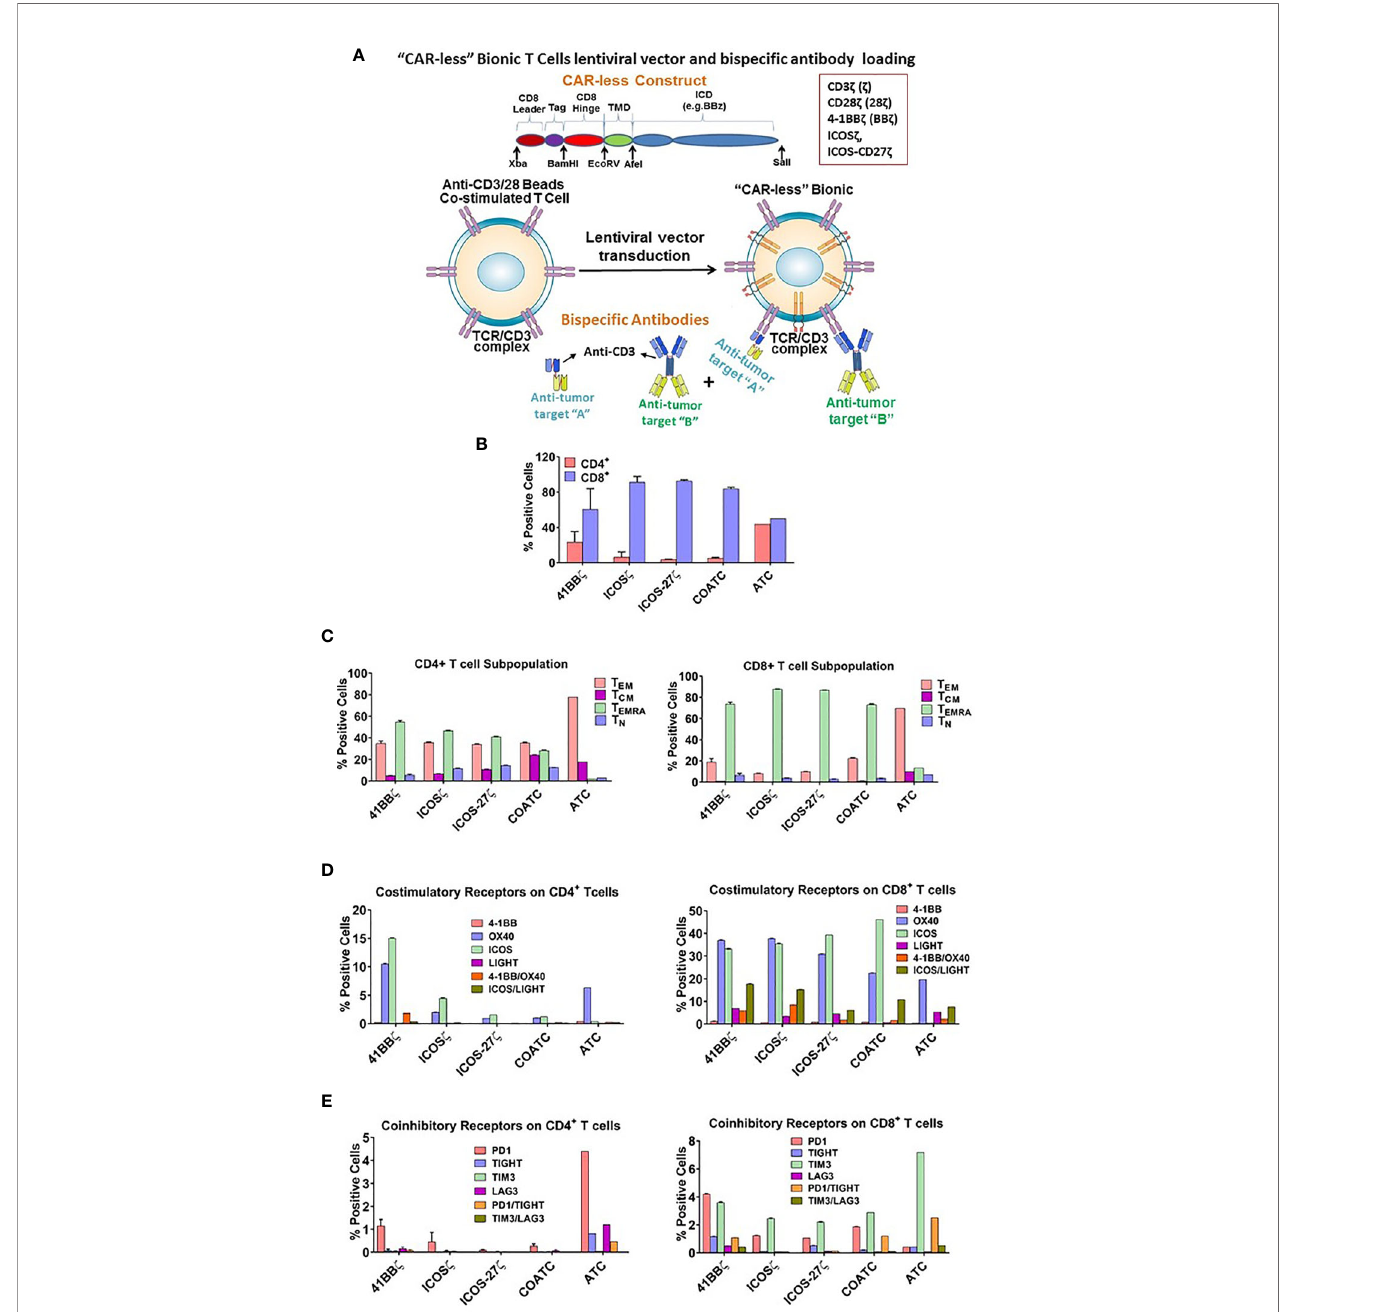
FIGURE 1 | (A) Vector Construct and Bispeci fi c Antibody Loading of Headless CAR T cells. Shows a sequence and basic structure of an intracellular signaling domain of the construct. The intracellular signaling domain includes a fusion protein with a detectable tag, hinge/transmembrane domain, and intracellular domain inserted in lentivirus vector. T cells are co-activated with anti-CD3/anti-CD28 antibody coated beads, transduced with lentivirus vector and expanded for 10-14 days in IL-2. Co-activated T cells (COATC) containing the intracellular signaling domain are de fi ned as “ Headless CAR T cells ” (hCART) and targeting ability of hCART is facilitated by loading or arming them with bispeci fi c antibodies (BiAb) that are produced either by chemical heteroconjugation of whole IgG molecules with Fc-Fc permanent covalent linker or by recombinant technology. hCART can be armed with single, dual, or triple loading with one, two, or three different BiAbs to target multiple tumor antigens. (B) T cell Subpopulations and Stimulatory/Inhibitory Co-Receptor Expression on hCART. (B) shows the CD4 + /CD8 + T cell ratios of